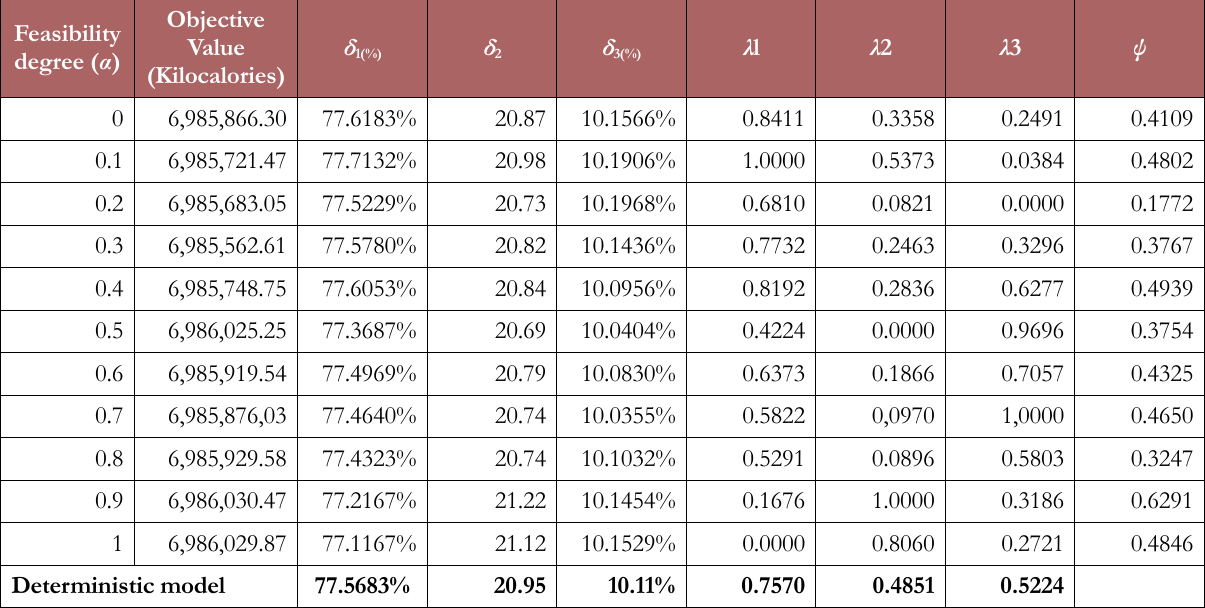
Table 4. Calculation of satisfaction levels by indicator for each α